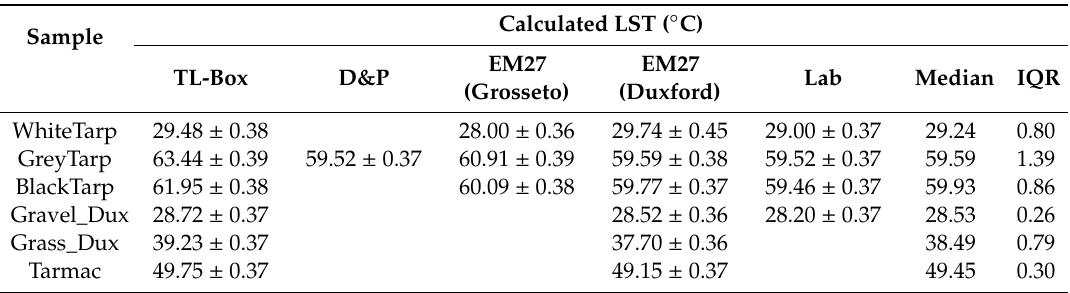
Table 6. Calculated LSTs and LST uncertainties ( ◦ C) for the six samples, each calculated using the emissivities derived with the various field and laboratory emissivity measurement methods considered herein, with the median and interquartile range (IQR) for each